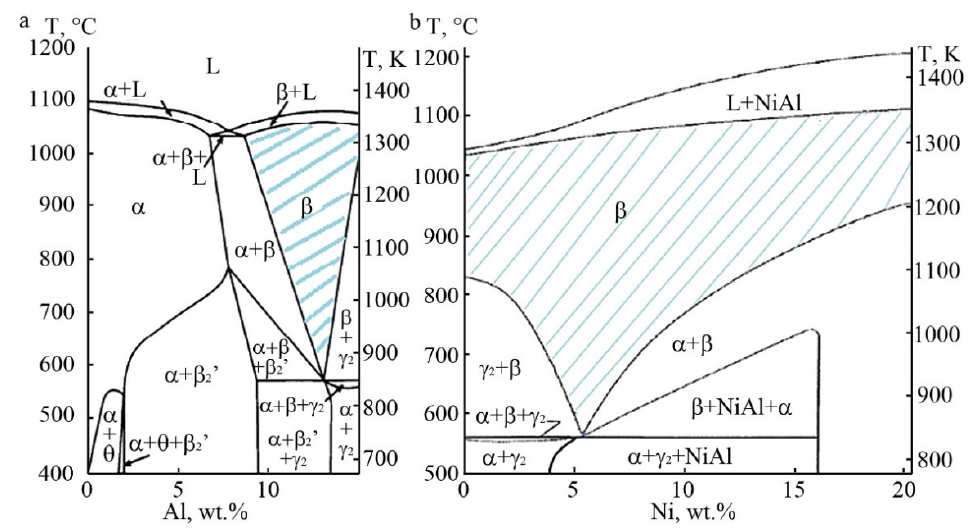
Figure 1. Phase equilibrium diagrams ( a ) Cu-Al-3 wt.%Ni and ( b ) Cu-14 wt.%Al-Ni [4]. Table 1. Mechanical properties, average grain size <d> and temperatures A s and A f of Cu-xAl-3 wt.%Ni alloys.